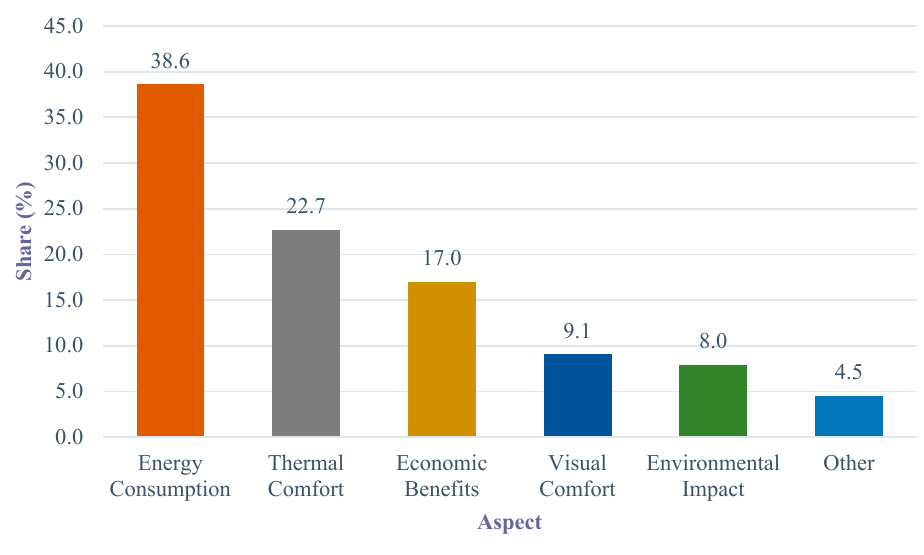
Figure 4. Share of each aspect in the optimization studies. Table 3. The aspects which have been considered as the optimization objective functions in the core literature.